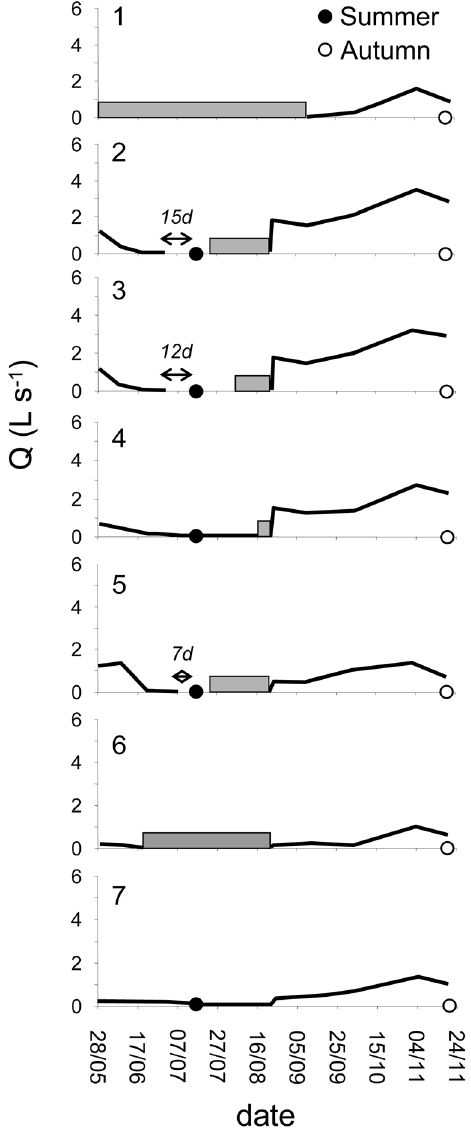
N )=summer sampling;